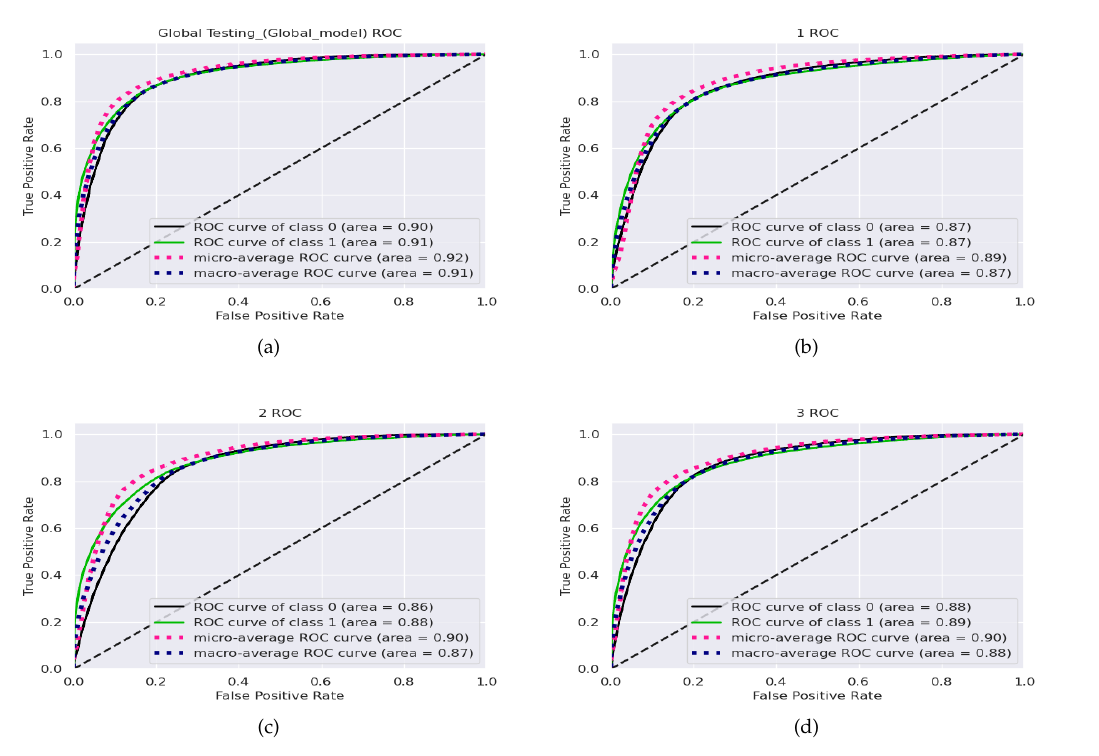
Figure 6. Receiver-operating curves for the ( a ) global model and the ( b ) client 1, ( c ) client 2, and ( d ) client 3 local models with the combined BHI test dataset and FL + ResNet50 + GaborNet.